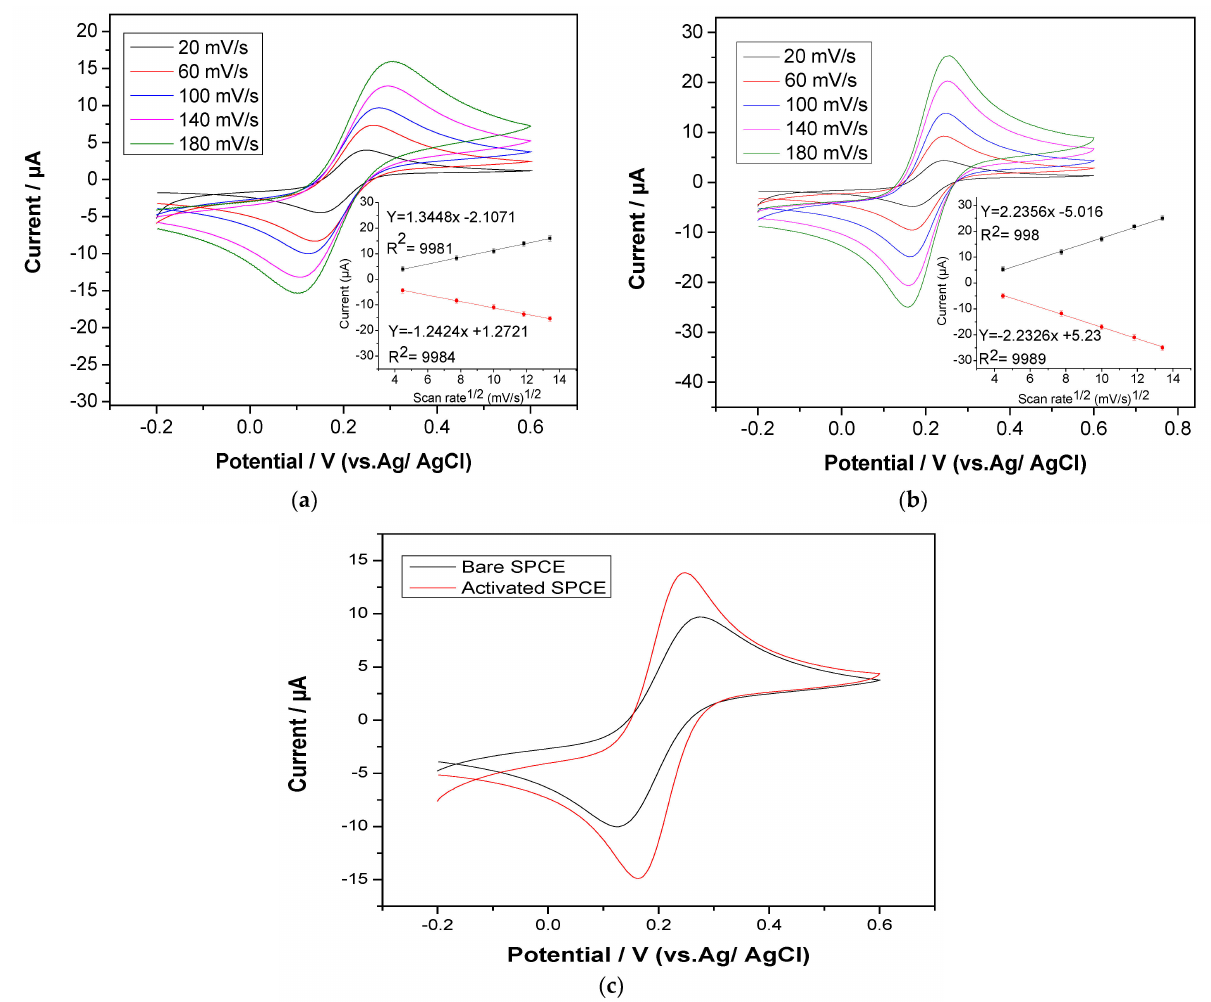
Figure 2. Cyclic voltammograms and plots of peak current vs. square root of scan rate (inset) of bare SPCE ( a ) and activated SPCE ( b ) with various scan rates from 20 mV/s to 180 mV/s. ( c ) The cyclic